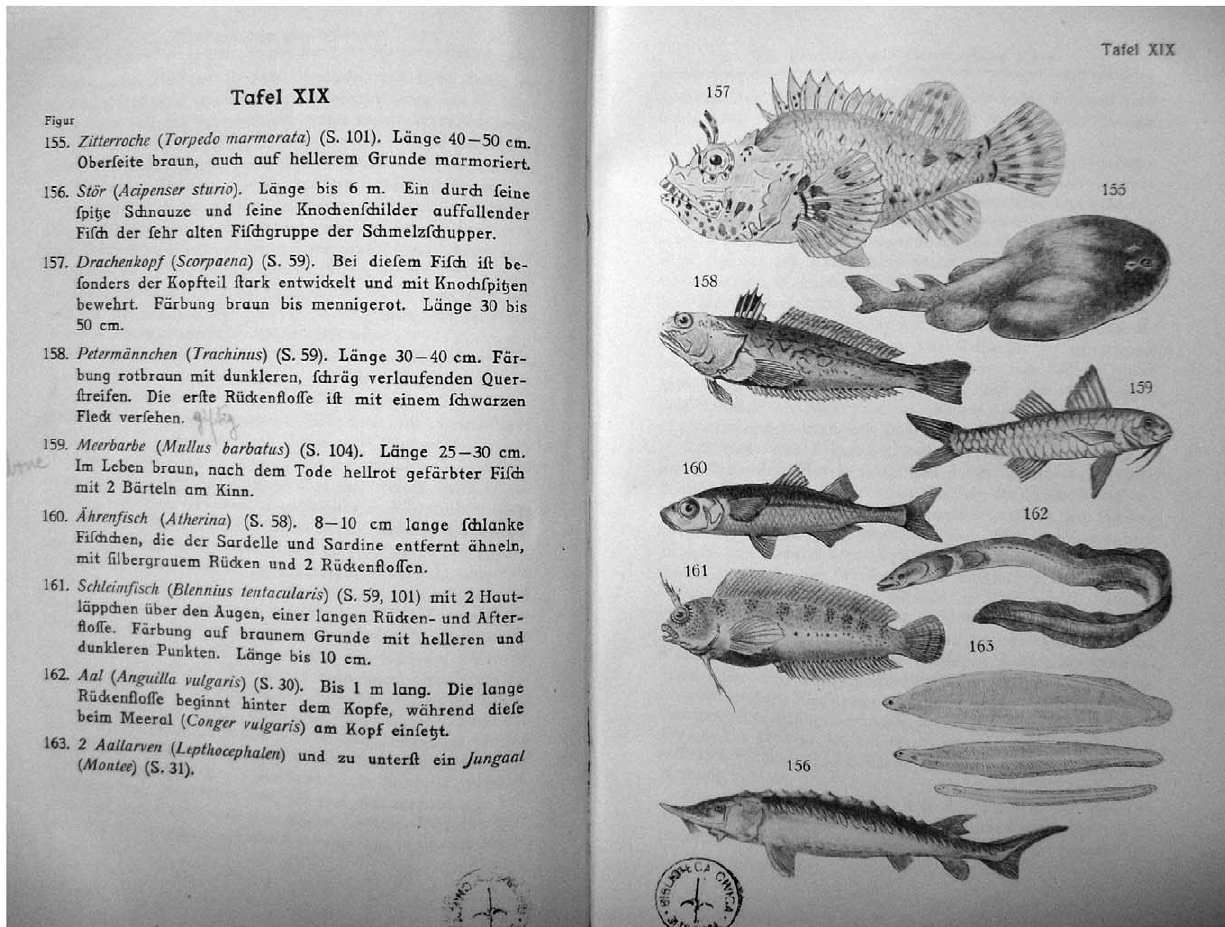
Figure 1. A naturalist’s catalogue of species. Cori C.I. (Leipzig, 1910). Der naturfreund am strande der Adria und des mittelmeeregebietes.